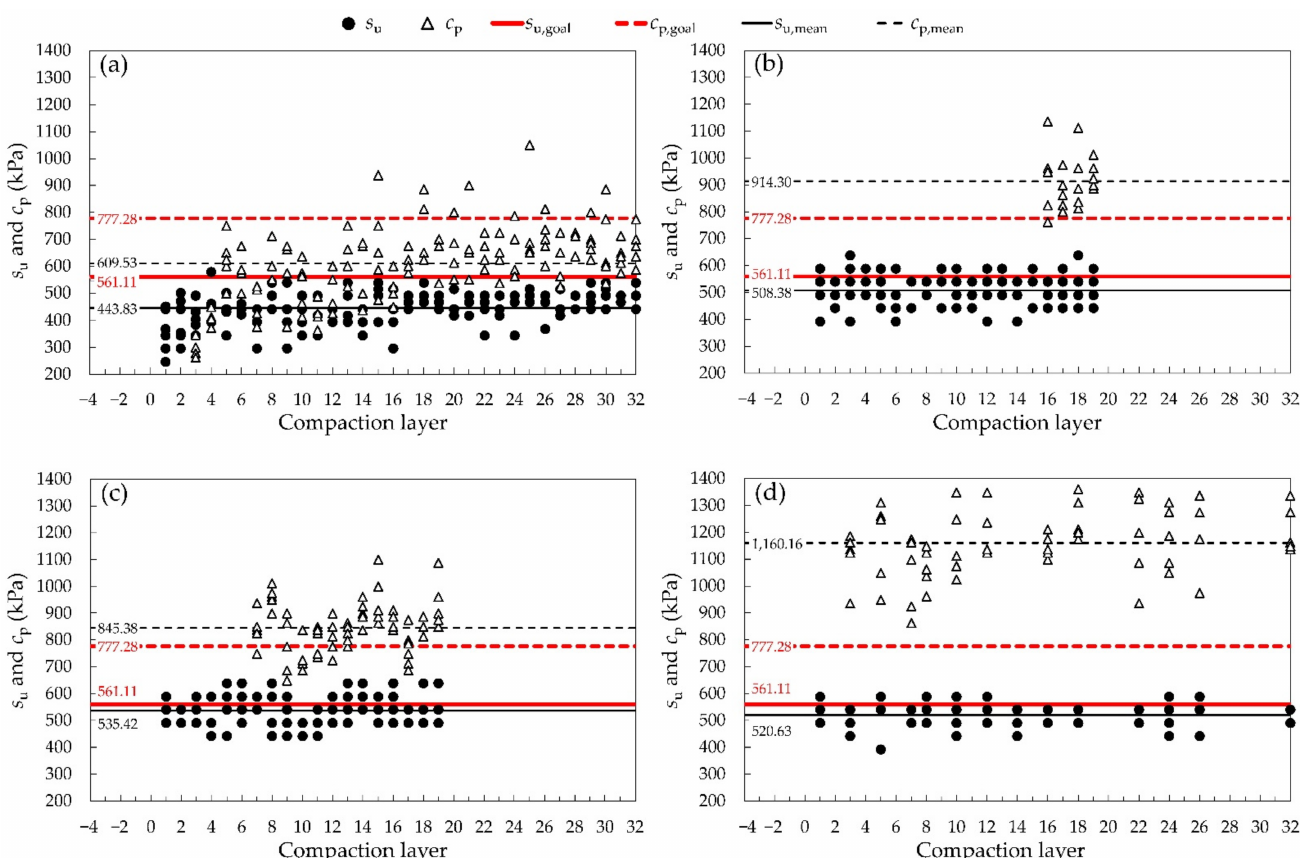
Figure 9. Strength measurements obtained during the construction of cohesive cores with the Geotester Pocket Penetrometer ( c p ) and the Humboldt H − 4212MH Pocket Shear Vane Tester ( s u ). Cohesive cores used for ( a ) PRELIM1 and PRELIM2, ( b ) MAIN1, ( c ) MAIN2; ( d ) MAIN3 and MAIN3+ (Table 4). The strengths s u,goal and c p,goal are estimates for a CB18 mixture with an optimal moisture content of 20.0% and a relative maximum dry density ρ d,max = 1692 kN · m − 3 (Figure 8). On the other hand, s u,mean and c p,mean are the average strengths using all